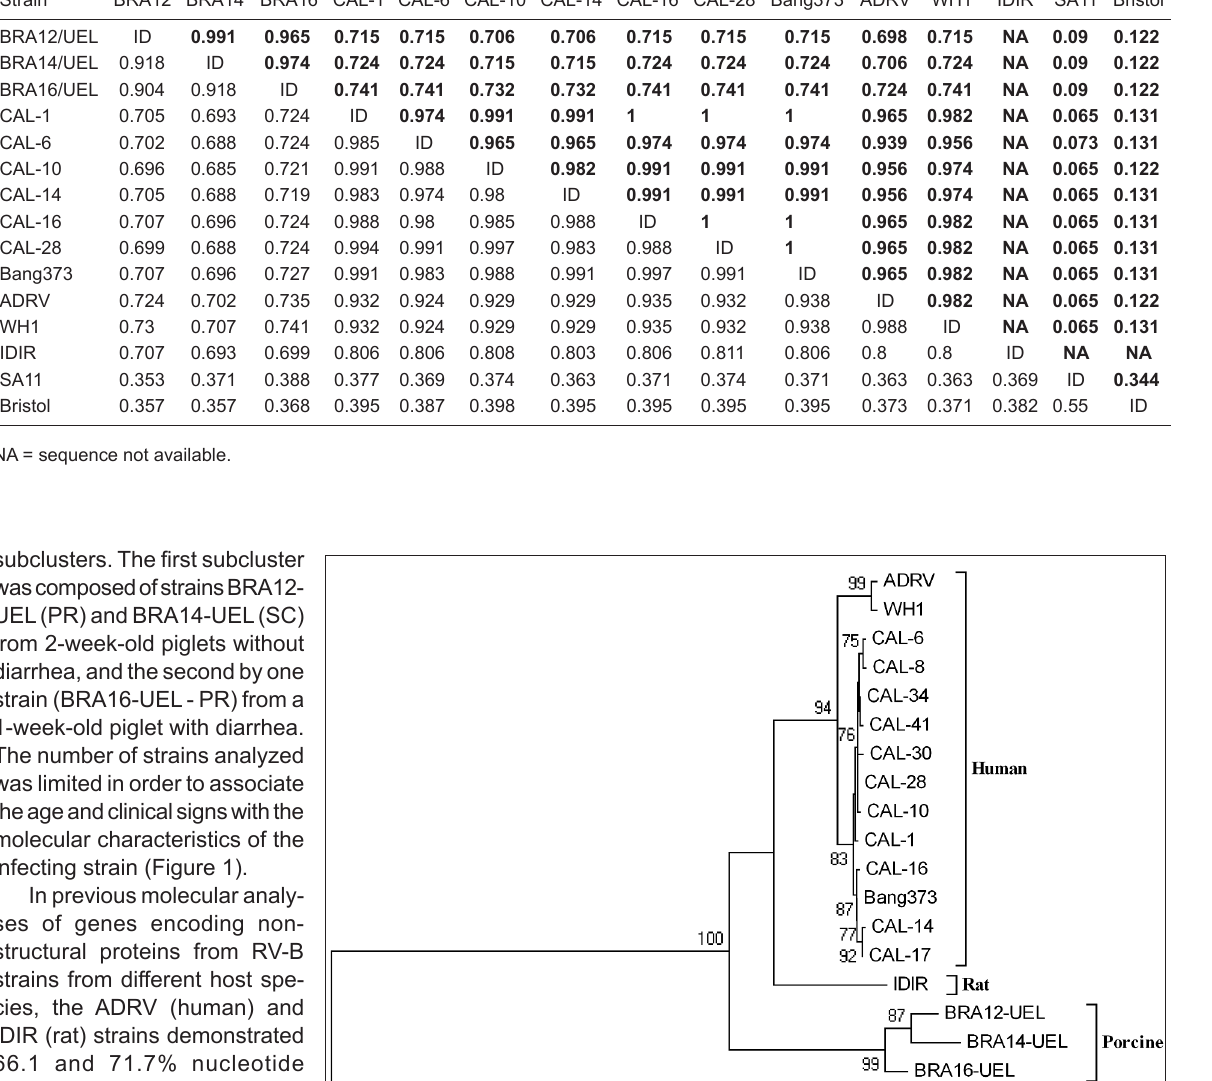
Table 1. Nucleotide (normal type) and amino acid (bold type) identity matrix of part (356 nucleotides and 116 amino acids) of the NSP2 gene among Brazilian and published sequences of group A, B, and C rotaviruses. Strain